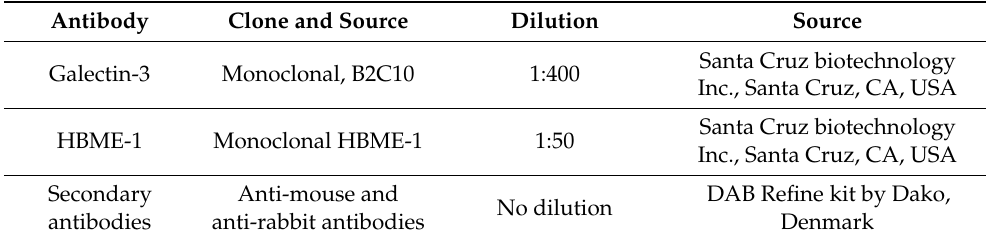
Table 1. Details of primary antibodies used for immunohistochemical analysis.